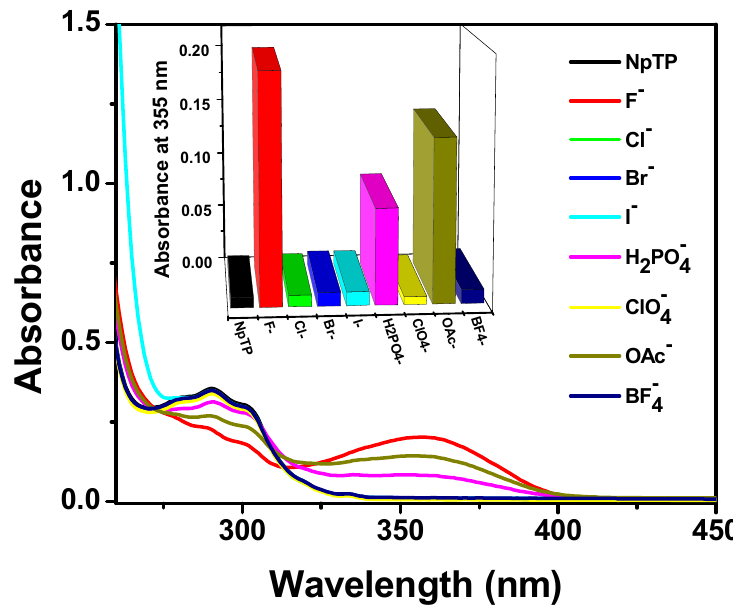
Figure 8. Absorption spectra and bars (in the inset) representing the spectral response of NpTP (~1 × 10 − 5 M) upon the addition of 4 × 10 − 4 M of various anions in acetonitrile. The bars in the inset are plotted by monitoring the absorbance of NpTP at 355 nm in presence of anions.